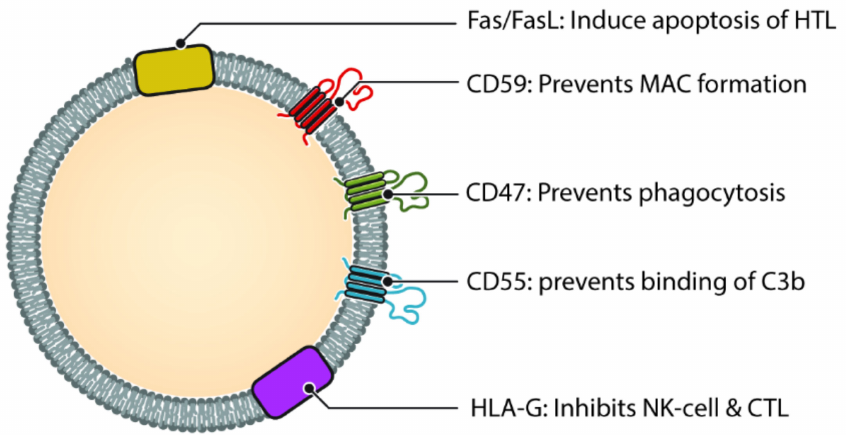
Figure 3. Different molecules that help exosomes escaping complement and immune system. Helper T cell (HTL), Natural Killer cell (NK Cell) and Cytotoxic T-lymphocyte (CTL). CD47, CD55 and CD59 help prevent the exosome from being destroyed by the complement cascade, either directly (via MAC) or indirectly. Molecules such as HLA-G and Fas/FasL protect the exosome from immune mediated destruction via cell mediated immunity (Cytotoxic T cell and NK